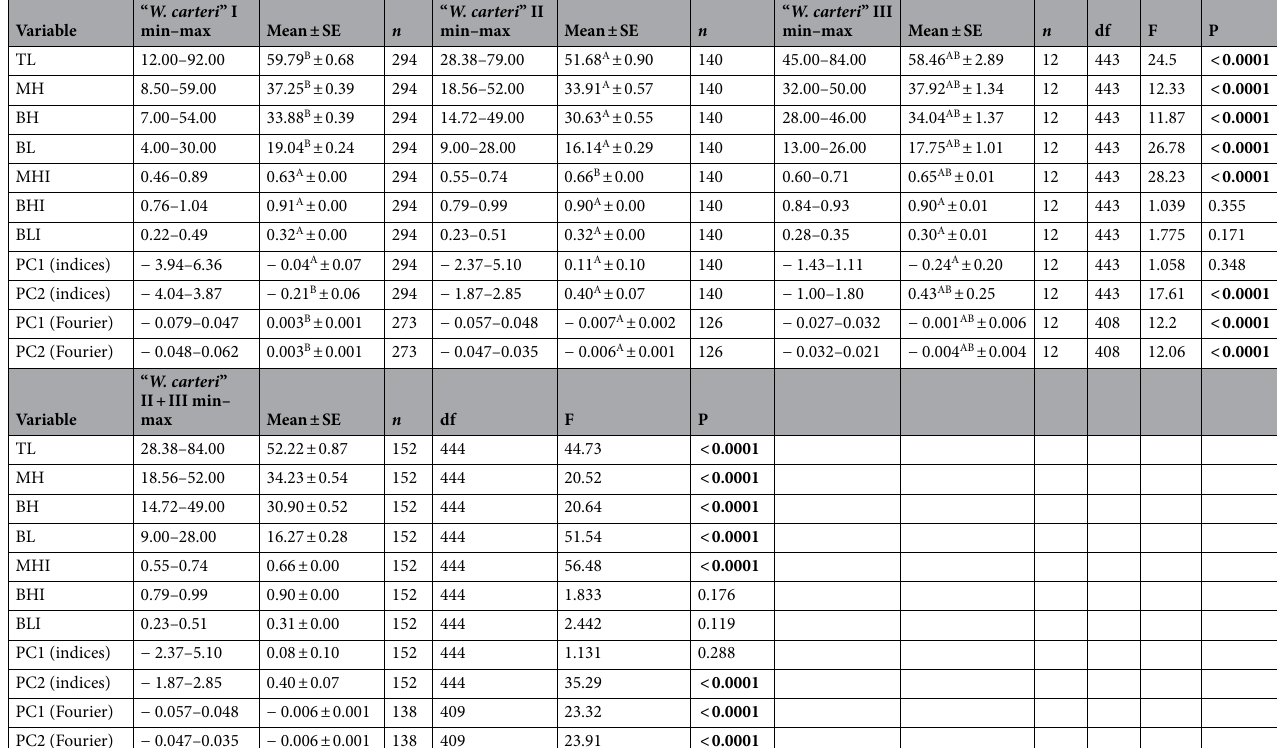
Table 2. Shell size metrics [mm], shape indices [%] and scores for the first two principal components (PC) obtained by Principal Component Analysis of shape indices and 18 Fourier coefficients generated by Fourier Shape Analysis for each “ Westralunio carteri ” species and subspecies-level Evolutionarily Significant Units (ESUs): n , number of specimens measured; minimum (min) to maximum (max) and mean (± standard error (SE)). P-value (P), degrees of freedom (df) and F-ratio (F) were obtained from ANOVAs comparing “ W. carteri ” I, II and III (upper section of the Table) and “ W. carteri ” I and II + III (lower section of the Table), respectively. P - values < 0.05 in bold; different superscript letters indicate significant differences between groups in Tukey’s pairwise posthoc-test. Shell size metrics: TL total length, distance from anterior to posterior apices of valve; MH maximum height, distance from ventral edge to apex of posterior ridge; BH beak height, distance from ventral edge to beak apex; BL beak length, distance from anterior apex of valve to the 90-degree vertex aligning with the beak apex. Shape indices determined as: MHI = MH/TL, BHI = BH/MH, and BLI =